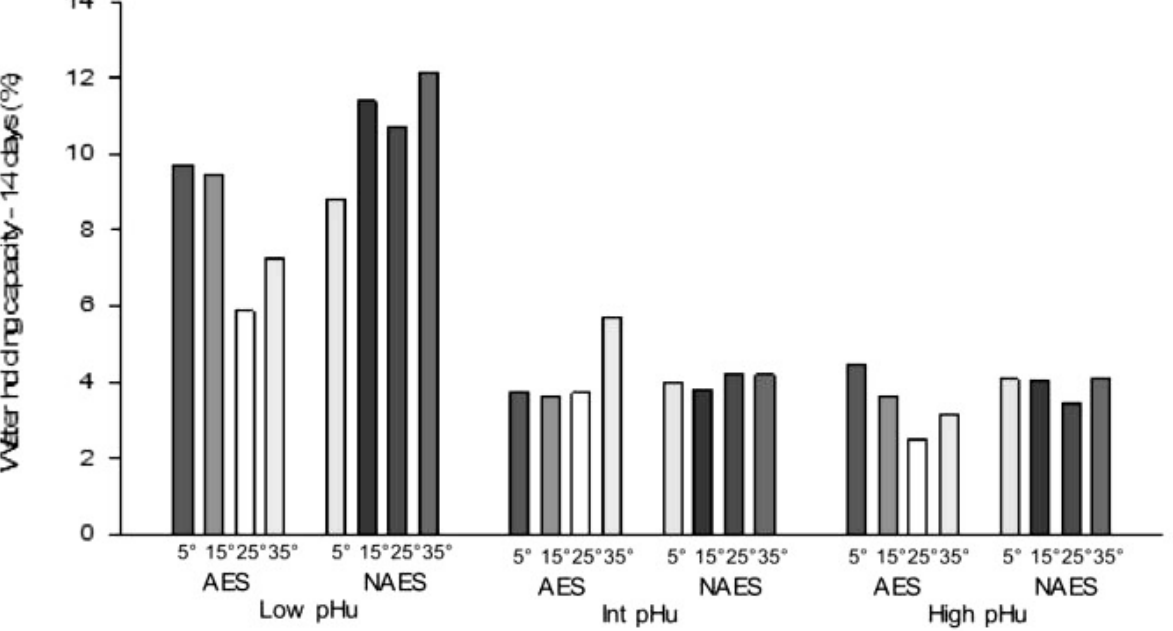
Figure 7. Effect of AES and various pre-rigor holding temperature (for 3 h) methods on water holding capacity (% loss) (14 days post mortem) of low, intermediate and high pHu beef M. longissimus lumborum samples. AES, additional electrical stimulation; NAES, no additional electrical stimulation. Low pHu (n = 3), Int (intermediate) pHu (n = 3), and high pHu (n = 6). Treatment effect [AES vs ES] (p = 0.02); pH effect (p<0.05); temperature effect (p = 0.001); interaction effect (stimulation×temperature) (p = 0.002); (stimulation×temperature×pH) (p = 0.021, standard error of difference =